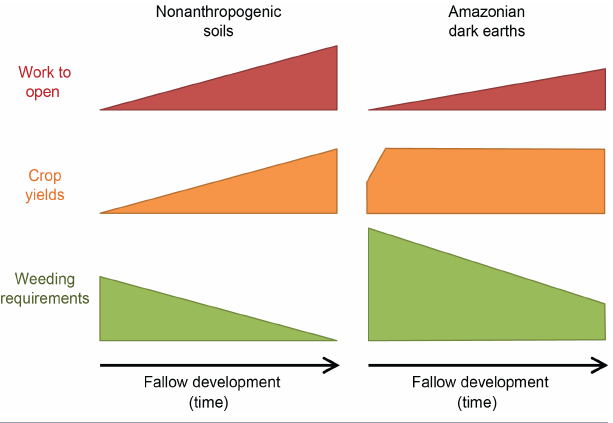
Fig. 2 . Conceptual diagram showing relationships between fallow length and work required to open the swidden, expected crop yields, and weeding requirements for nonanthropogenic (NAS) and anthropogenic soils (Amazonian dark earths, ADE). Farmers associate increased fallow development with increased work to open the swidden and with higher expected crop yields, but with decreased weeding requirements; this association is much weaker on ADE than on NAS because ADE is always associated with good crop yields and with high weeding